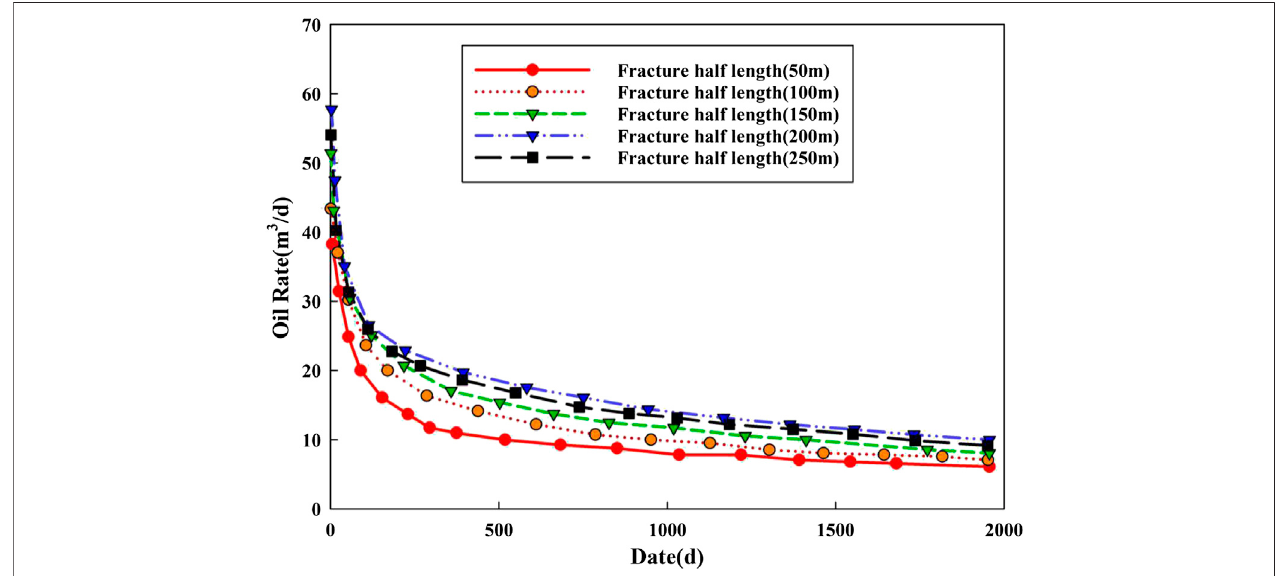
FIGURE 11 | Daily oil production curve of different fracture half length.